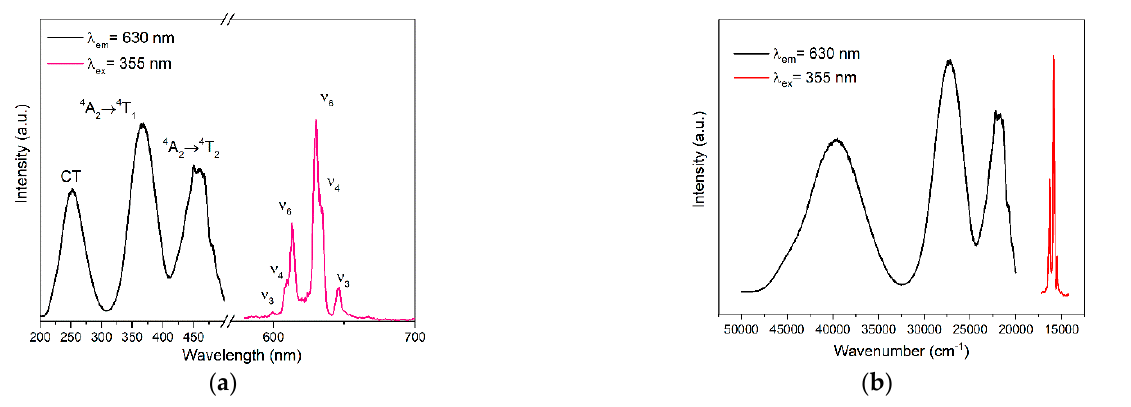
Figure 5. ( a ) PLE spectrum by monitoring at 630 nm, and PL spectrum with excitation of 355 nm of the [N(CH 3 ) 4 ] 2 ZrF 6 :1%Mn 4+ sample at room temperature. ( b ) PLE and PL spectra with abscissa ex- pressed in